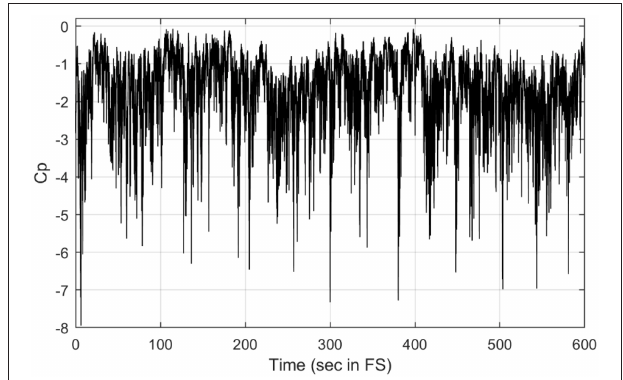
FIGURE 2 | Example Cp time series for Tap